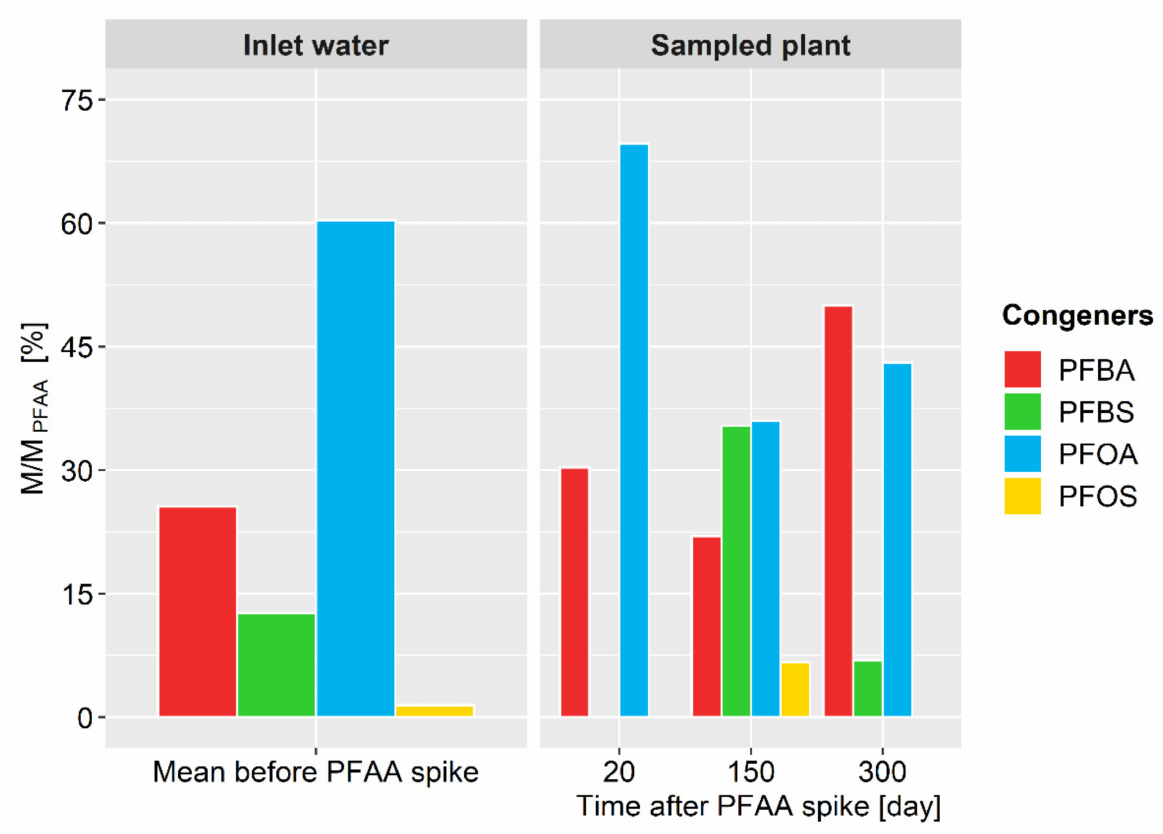
Figure 6. Percentage distribution of PFAAs in inlet water (left panel) “before PFAA spike”, and in reed grass samples (right panel) harvested about 20 days (t 20 ), 5 months (t 150 ) and 10 months (t 300 ) “after PFAA spike” in the